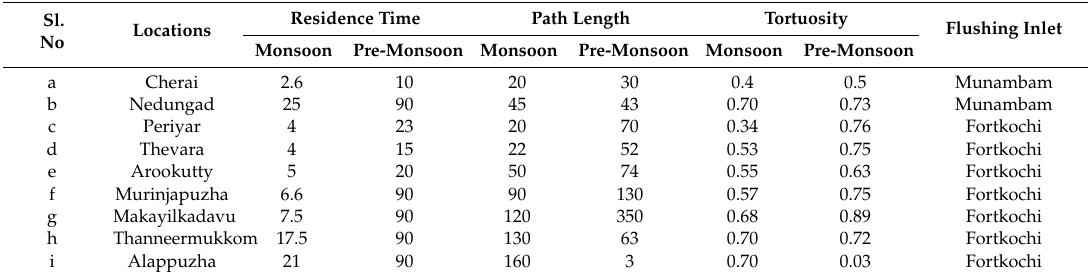
Table 5. Comparison of residence time, path length, tortuosity at various locations in the monsoon and pre-monsoon